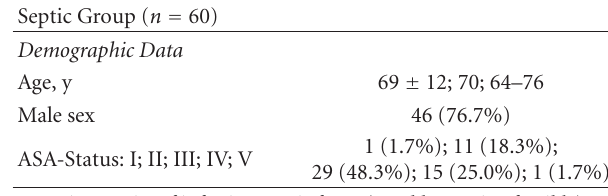
Table 1: Baseline data of 60 patients in the septic group, 30 patients in the surgical group and 30 individuals in the healthy